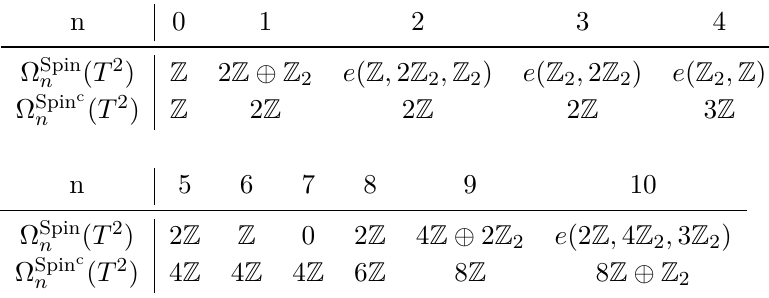
( T 2 ) and Ω Spin c ( T 2 ) , n = 0 , . . . , 10 n n